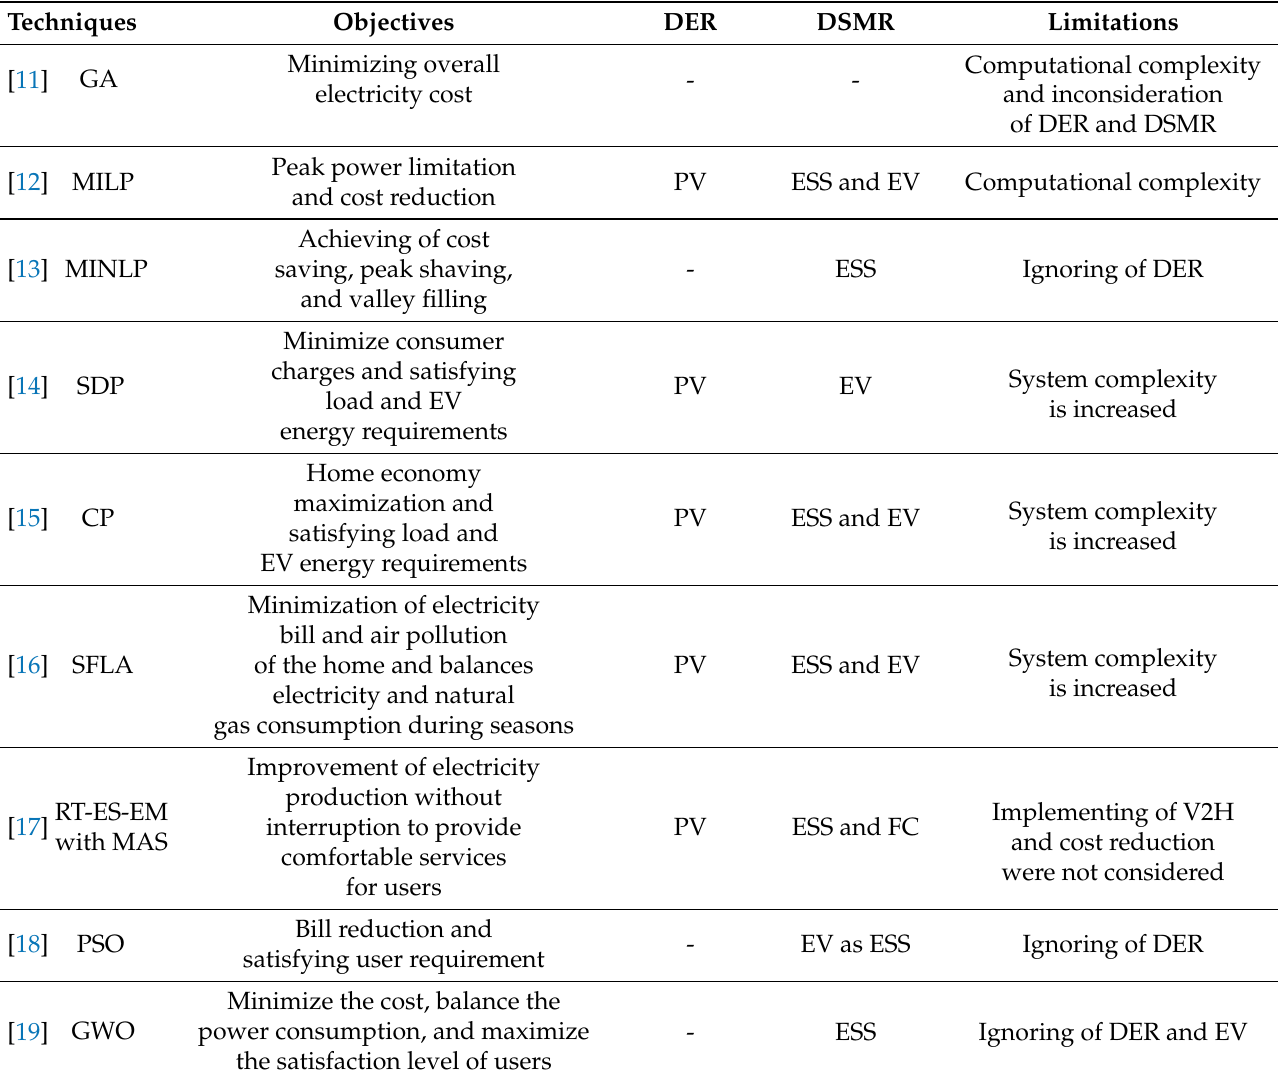
Table 1. Summary of